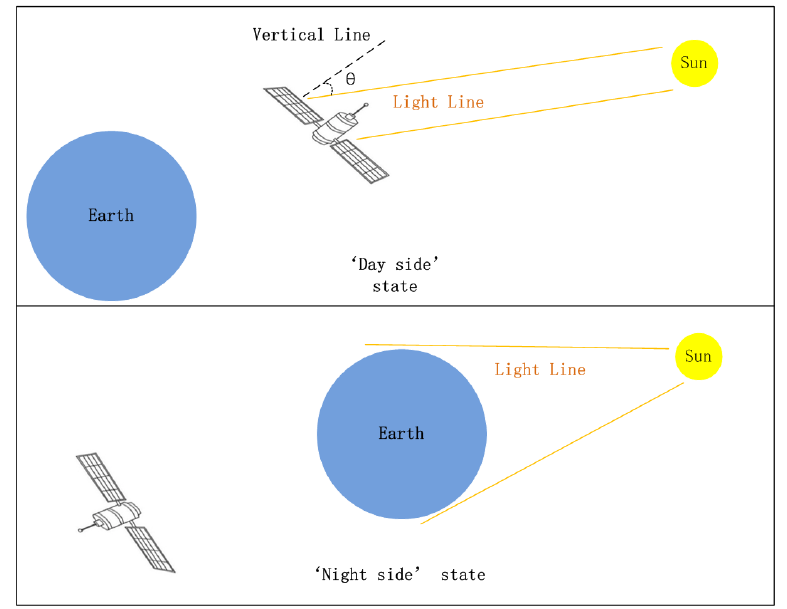
Figure 2. Satellites charging and discharging. In “day side”, charging power ( CP ) is related to satellite solar panel design and relative attitude; it can be described as: